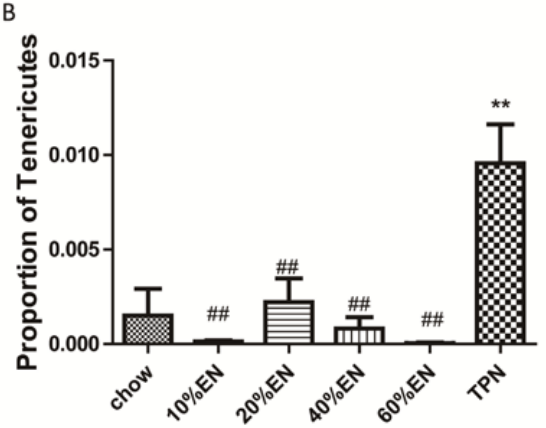
Figure 7. Proportion of Bacteroidetes and Tenericutes in the pyrosequencing analysis of ileal wash samples at the phylum level. ( A ) Bacteroidetes and ( B ) Tenericutes. Data are represented as the mean ˘ standard error of the mean (SEM). ** p < 0.001 vs. chow. ## p < 0.001 vs. TPN. EN: enteral nutrition; TPN: total parenteral nutrition.